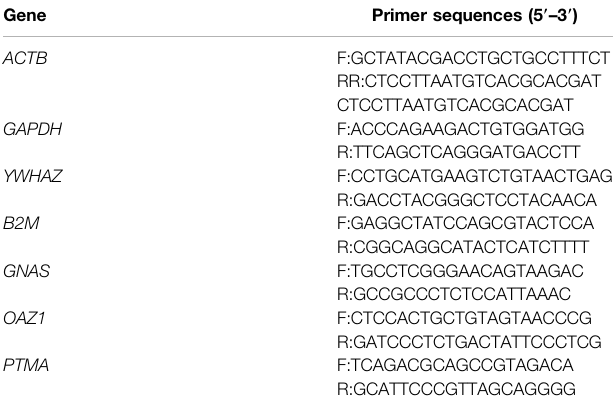
TABLE 2 | Primer sequences of the seven candidate reference genes.